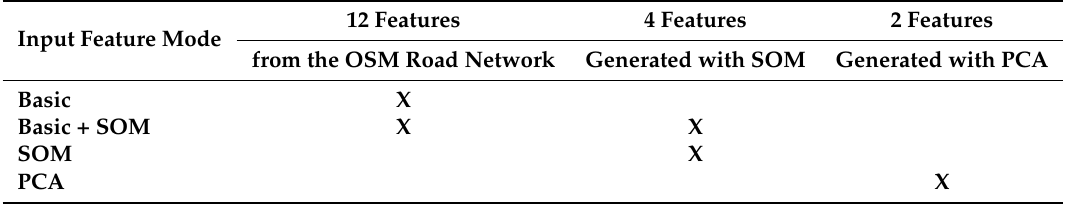
Table 4. Overview of the input features for the machine learning (ML)